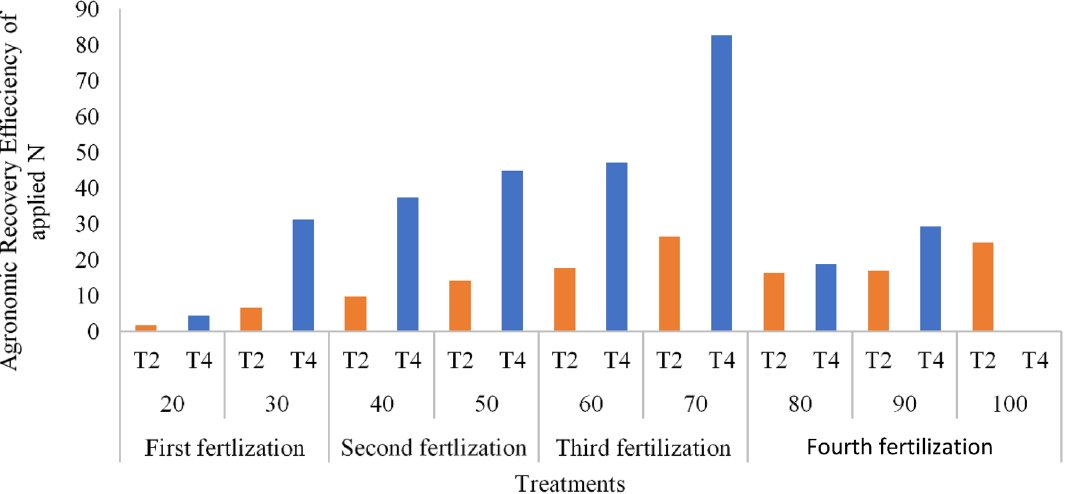
Figure 11. Chicken litter biochar on agronomic recovery efficiency (ARE) of applied